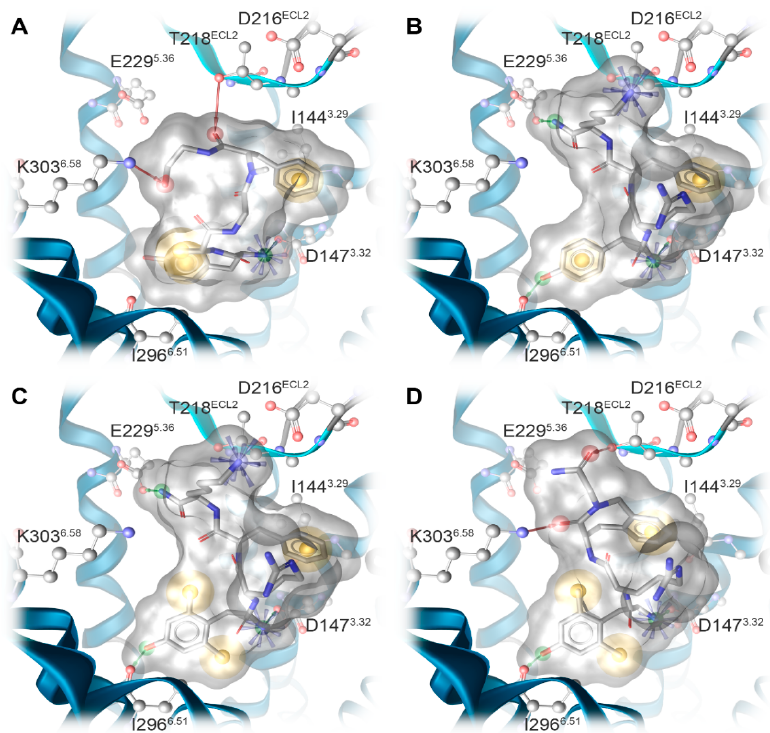
Figure 6. Predicted binding modes at the human MOR model (based on PDB ID: 6DDF) and receptor–ligand interaction patterns of opioid peptides ( A ) DAMGO, ( B ) DALDA, ( C ) [Dmt 1 ]DALDA, and ( D ) KGOP01. Yellow spheres indicate lipophilic contacts, red arrows hydrogen bond acceptors, green arrows hydrogen bond donors, and positively charged centers are shown as blue spheres.